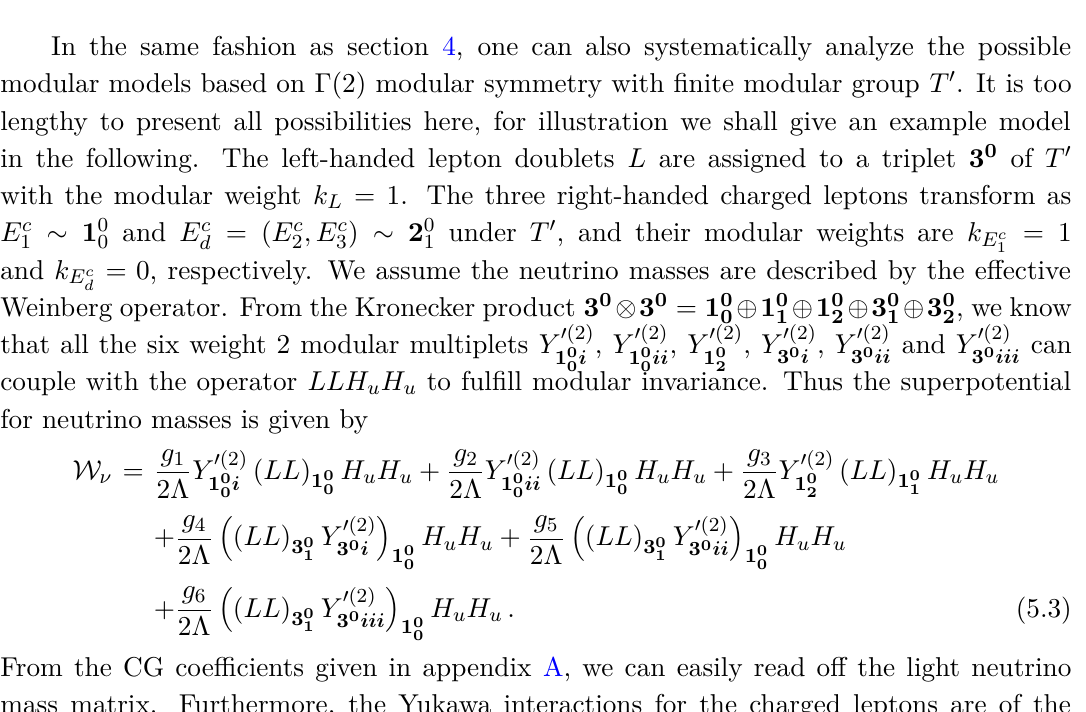
Figure 4 . The fundamental domain D